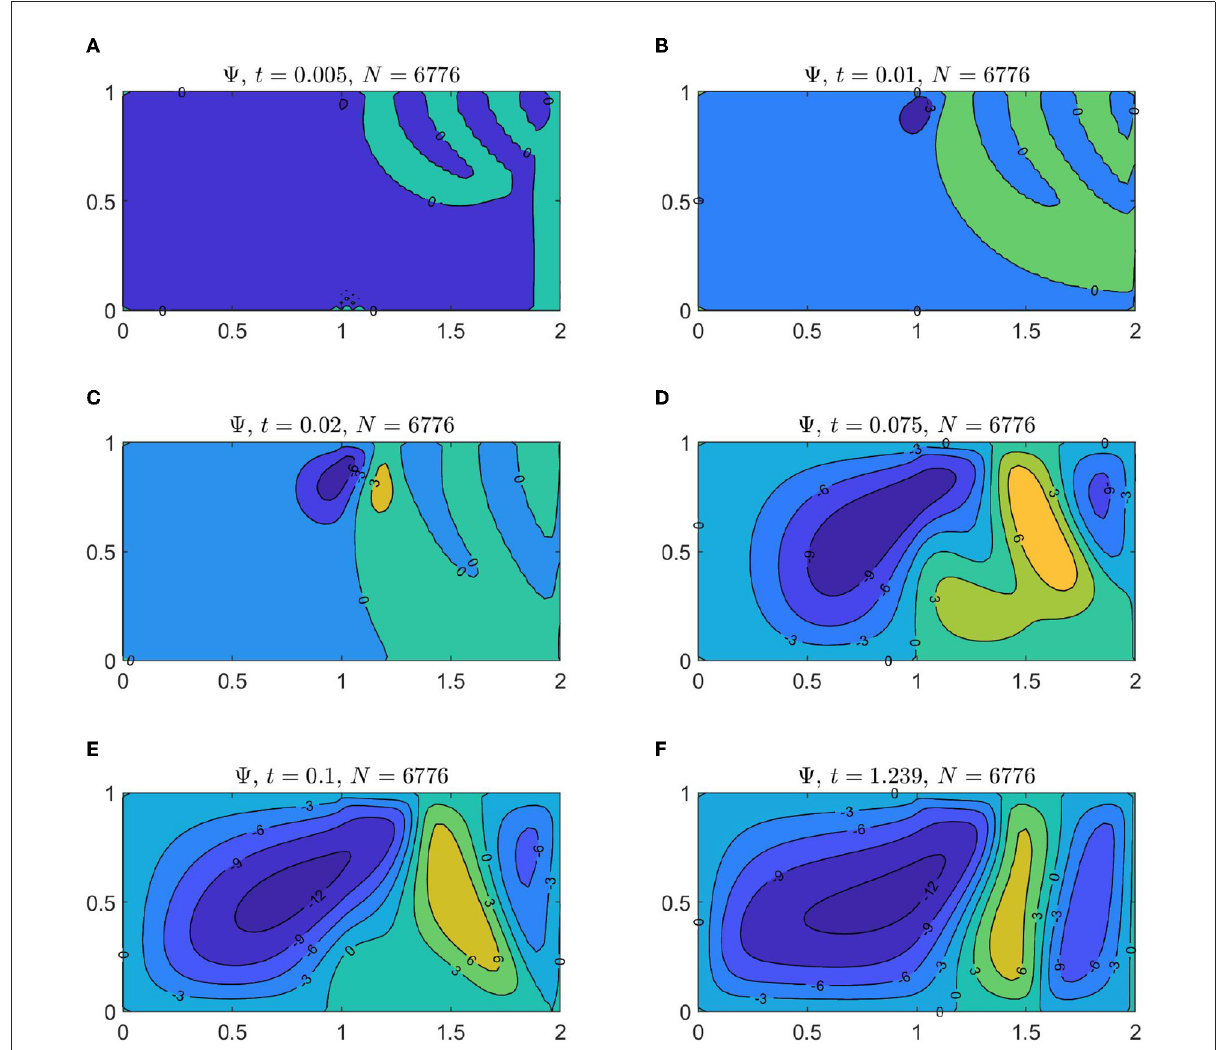
FIGURE15 Streamlines distribution for different times. (A) t = 0.005, (B) t = 0.01, (C) t = 0.02, (D) t = 0.075, (E) t = 0.1, and (F) steady-state time t = 1.239.